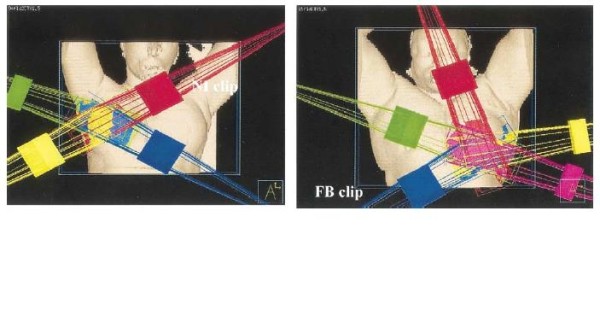
3D-CRT typical 4-field arrangement for right sided lesions and 5 field arrangement for left sided lesions (reprinted with permission from Baglan et al.[93].